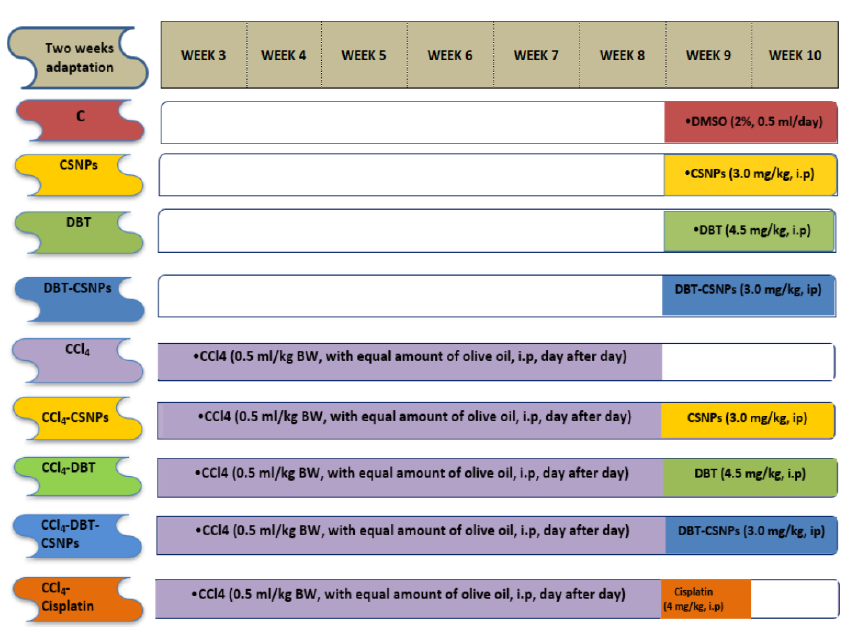
Figure 8. Illustration of the current experimental design. Figure 7. Illustration of the current experimental